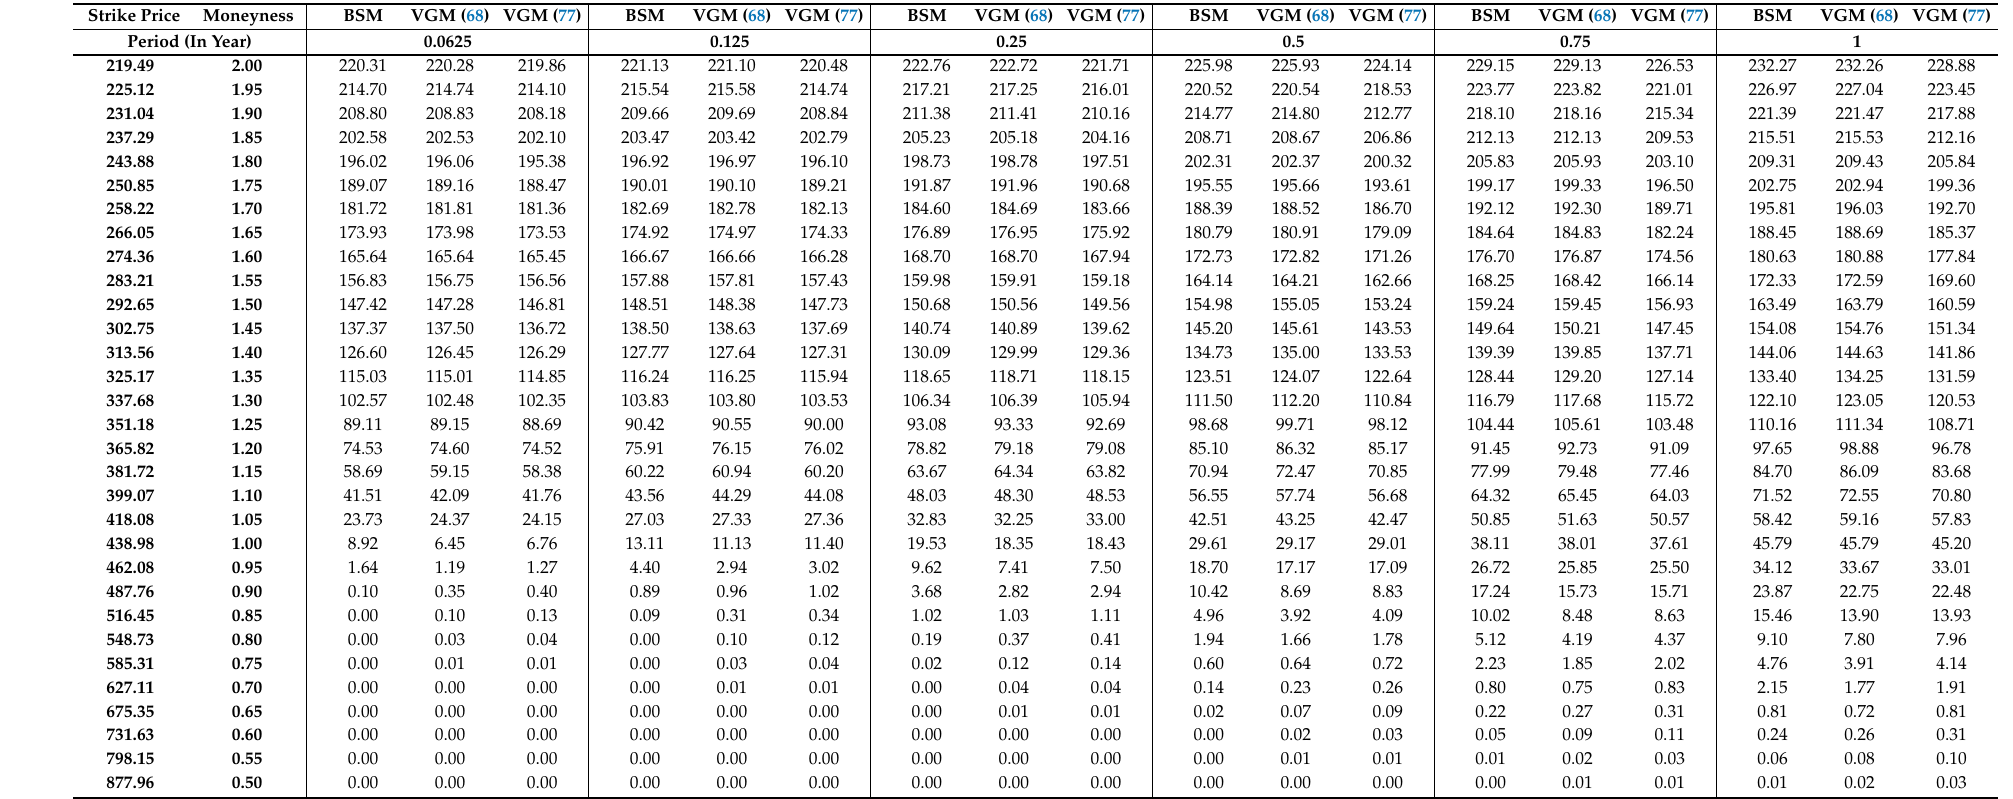
Table 3. Price of European call option on SPY